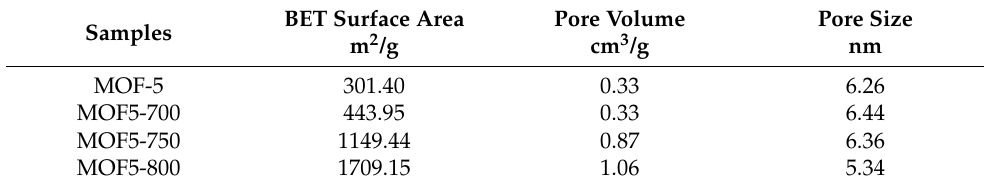
Table 3. Specific surface area pore volume and pore size data of each